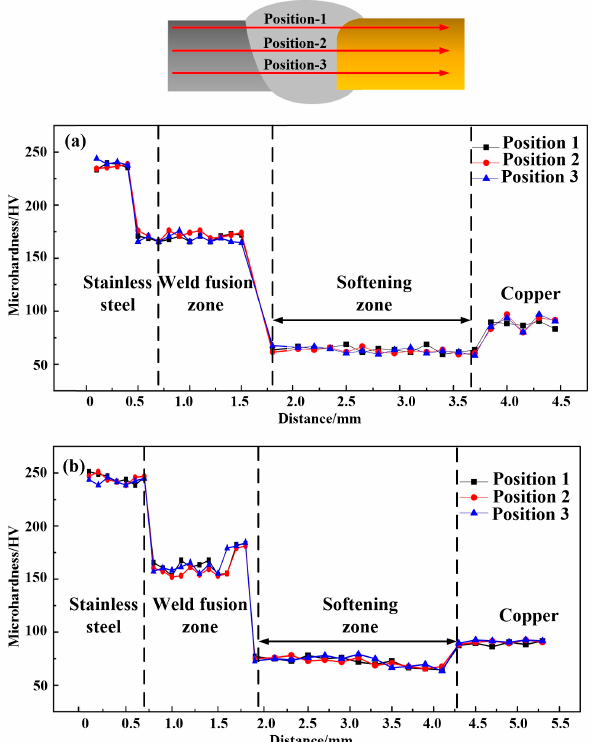
Figure 12. Microhardness distributions across the welds of joints: ( a ) joint 1 and ( b ) joint 2.